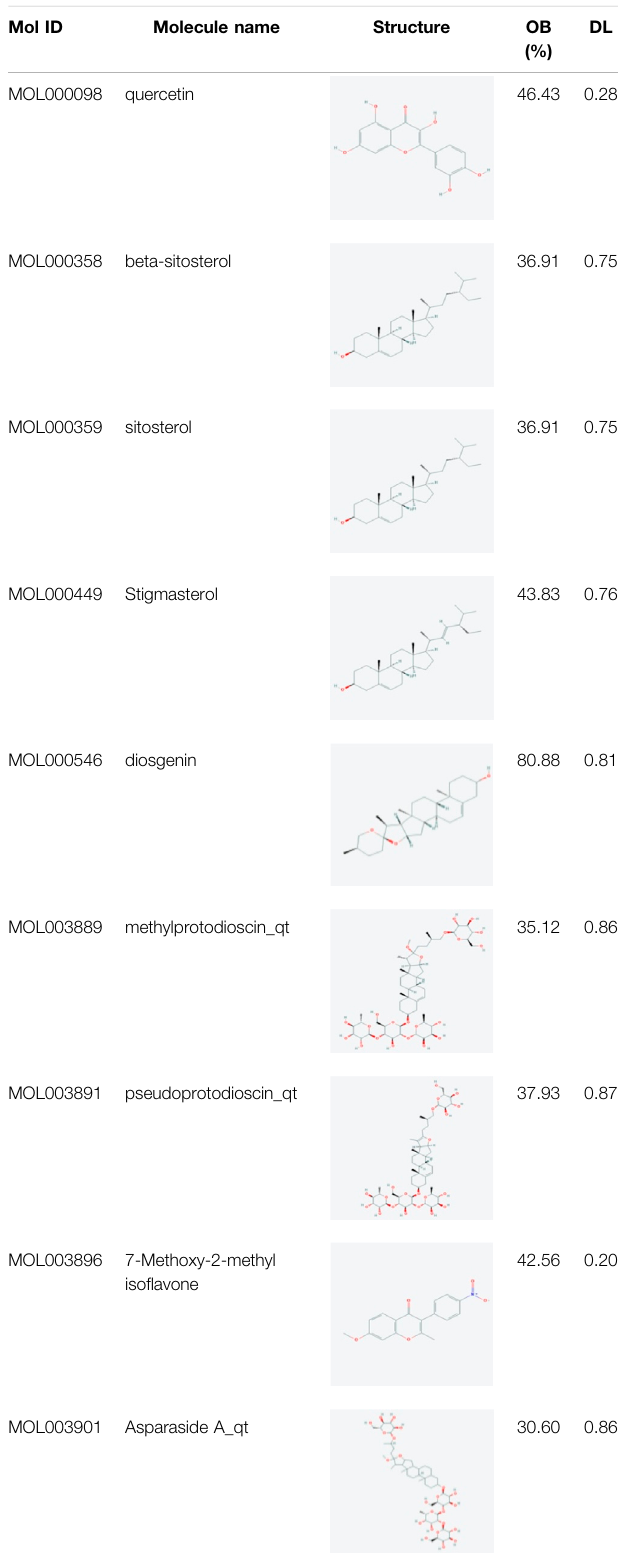
TABLE1| Activeingredientsandabsorbed,distributed,metabolizedandexcreted (ADME) parameters of ASP. Mol